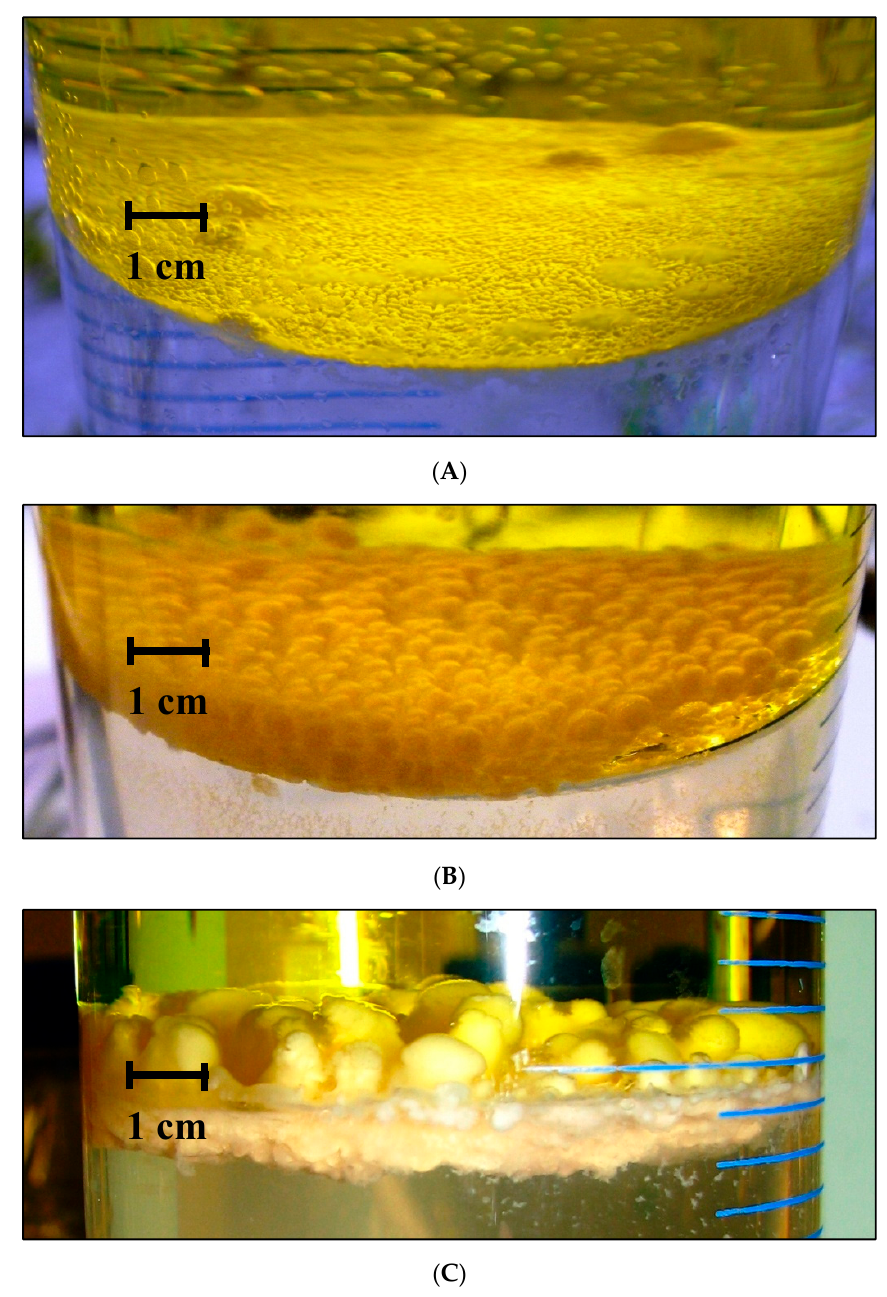
Figure 3. Biofilm formation at oil/water interface (diameter of the cylinder = 90 mm): ( A )—Biofilm growth under diffusion-limited conditions (2–3 mm, 60 days after incubation). ( B )—Biofilm growth under stirring, without limitations caused by diffusion (20 mm, 60 days after incubation). ( C )—Development of mature biofilm structure without limitations caused by diffusion (25 mm, 90 days after incubation).